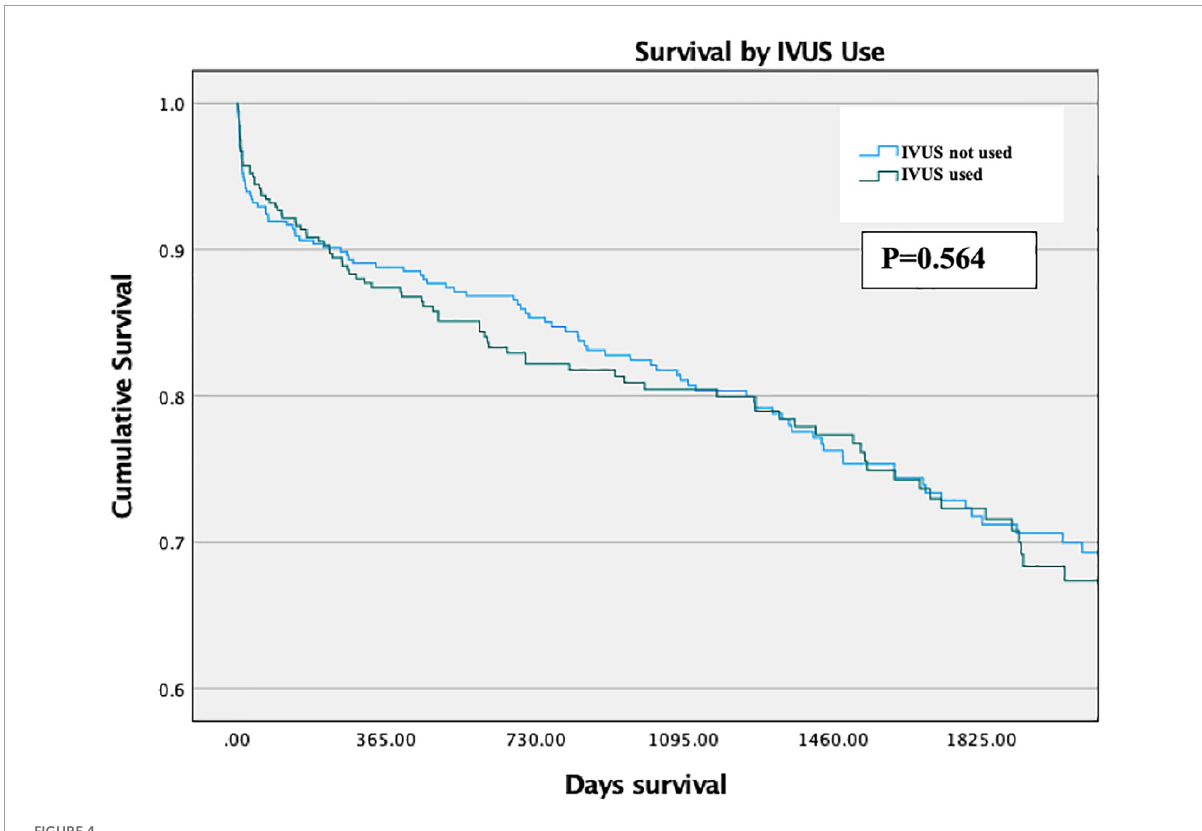
FIGURE4 Survival by IVUS use (propensity matched